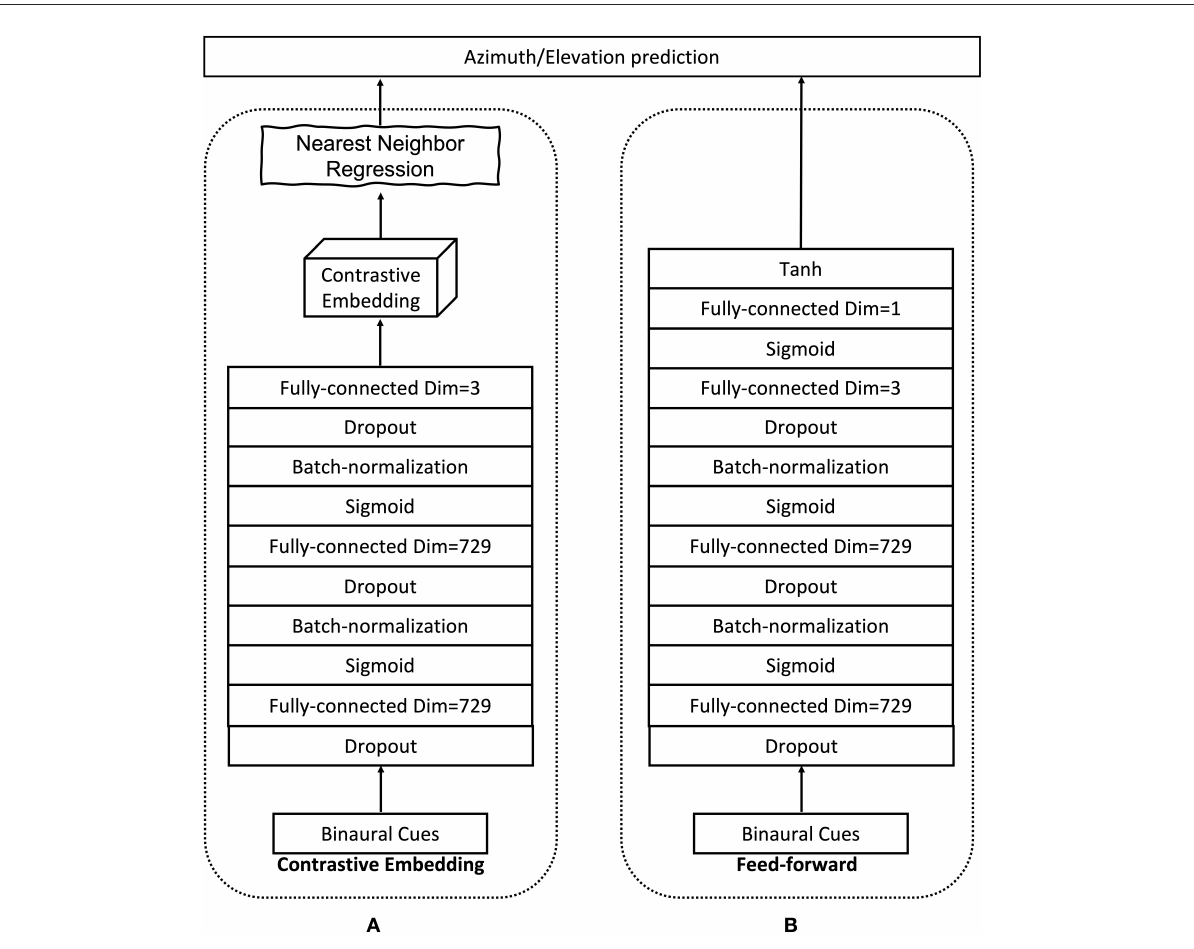
and i = 1 ... N . Note that, the original labels have a range [ − 180, 180 ◦ ]. During testing, the feed-forward predictions are firstly converted back to degree before calculating the localization